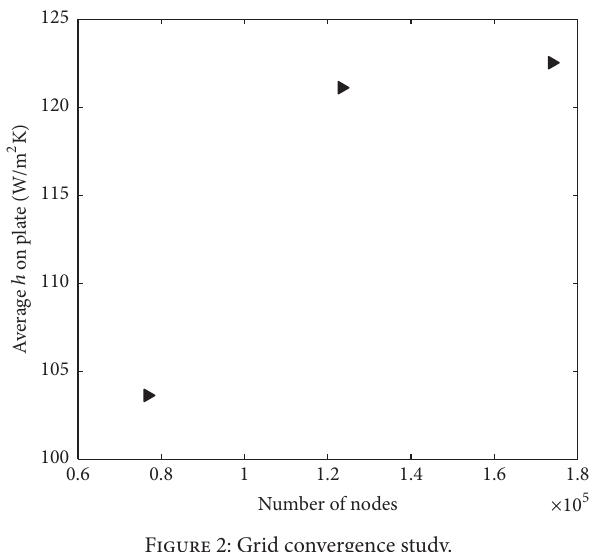
Figure 2: Grid convergence study.